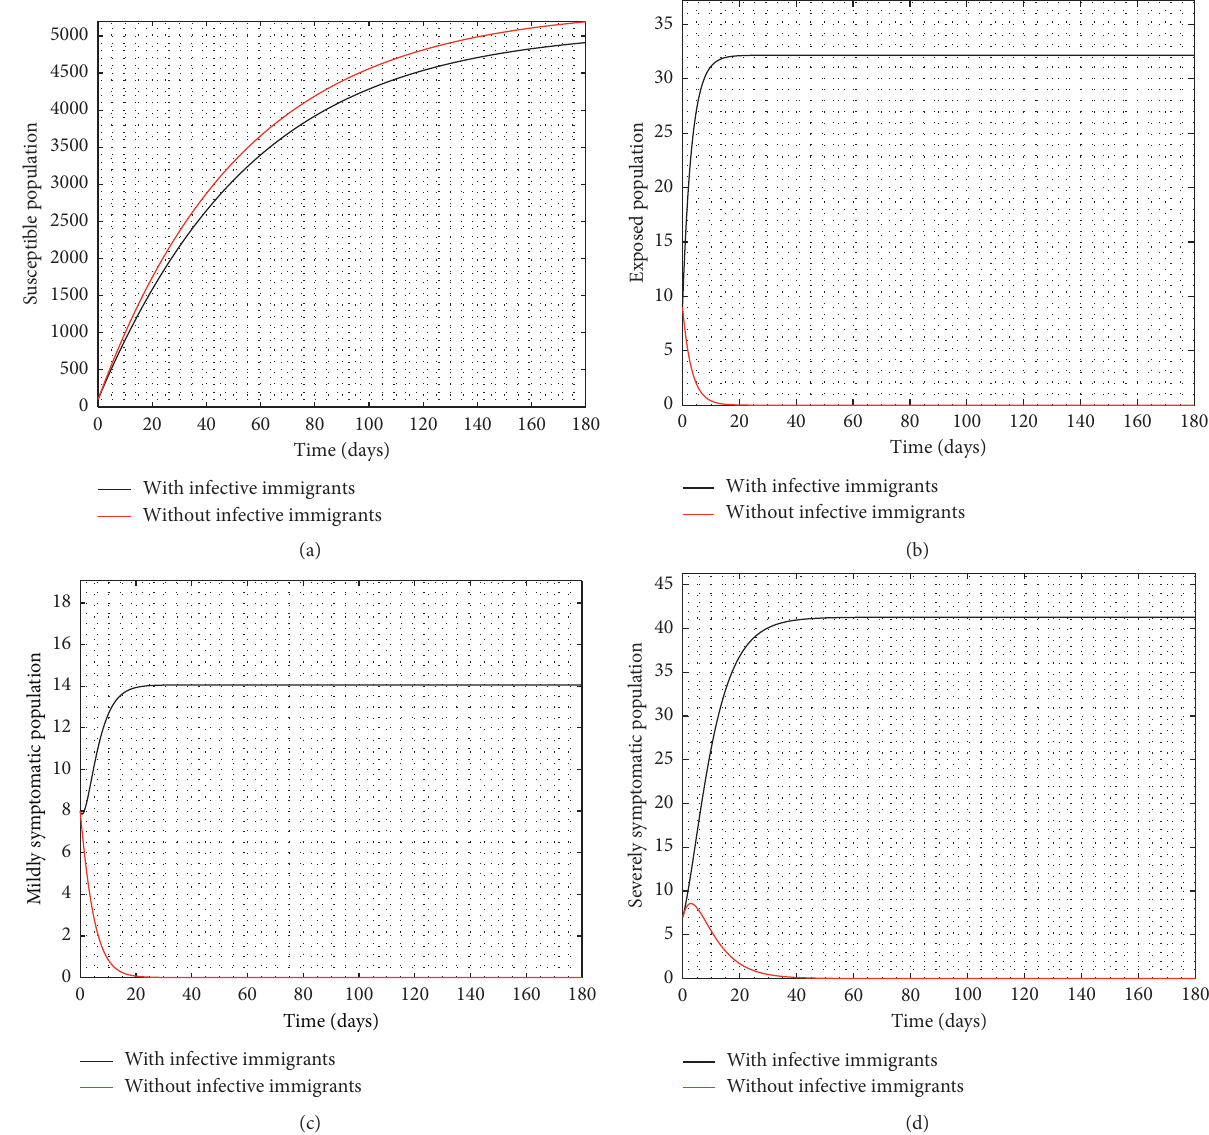
Figure 2: Time series of S , E , I